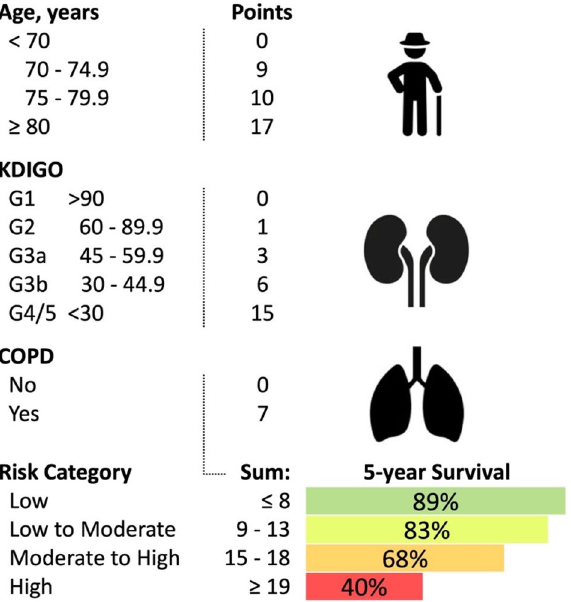
Figure 3. Predictive Score. Predictive score based on the Cox proportional hazard model presented in Table 4. Adding the points from Age, COPD and KDIGO gives a total score that determines the risk category. COPD: chronic obstructive pulmonary disease; KDIGO: kidney function as estimated glomerular filtration rate according to the “Modification of Diet in Renal Disease Study”